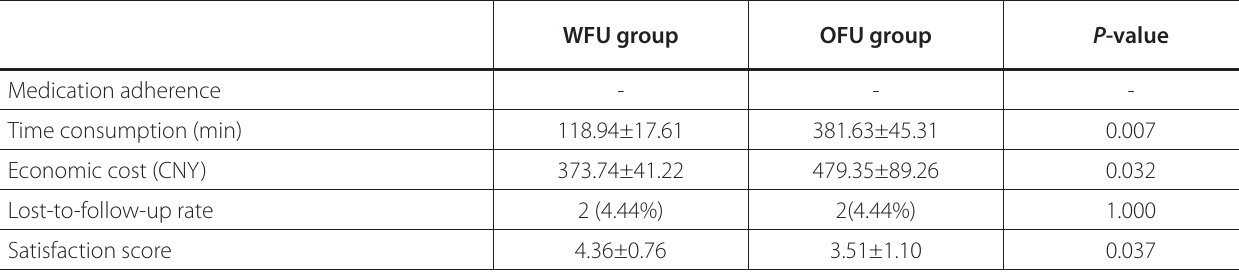
Table 3 . Comparison of the results between the two groups at the one-year follow-up.